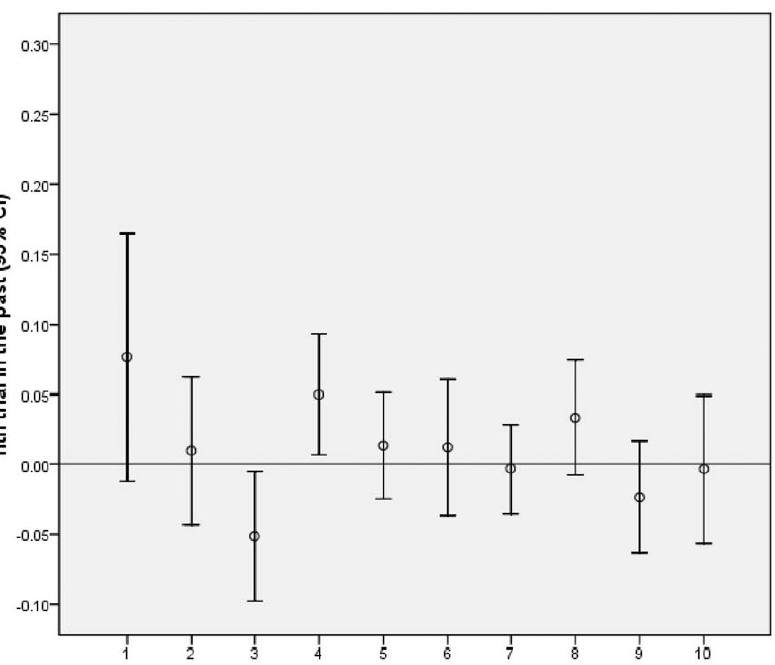
Figure 2. Results for testing whether learning is associative. Correlation of current prediction with what happened on the nth trial in the past plotted against trials into the past (n). Figure 2 shows no tone trials. Figure 2 is based on fewer trials than 1, hence the wider confidence intervals. The overall level of correlation is detectably stronger for Figure 1 rather than 2, indicating context is important.